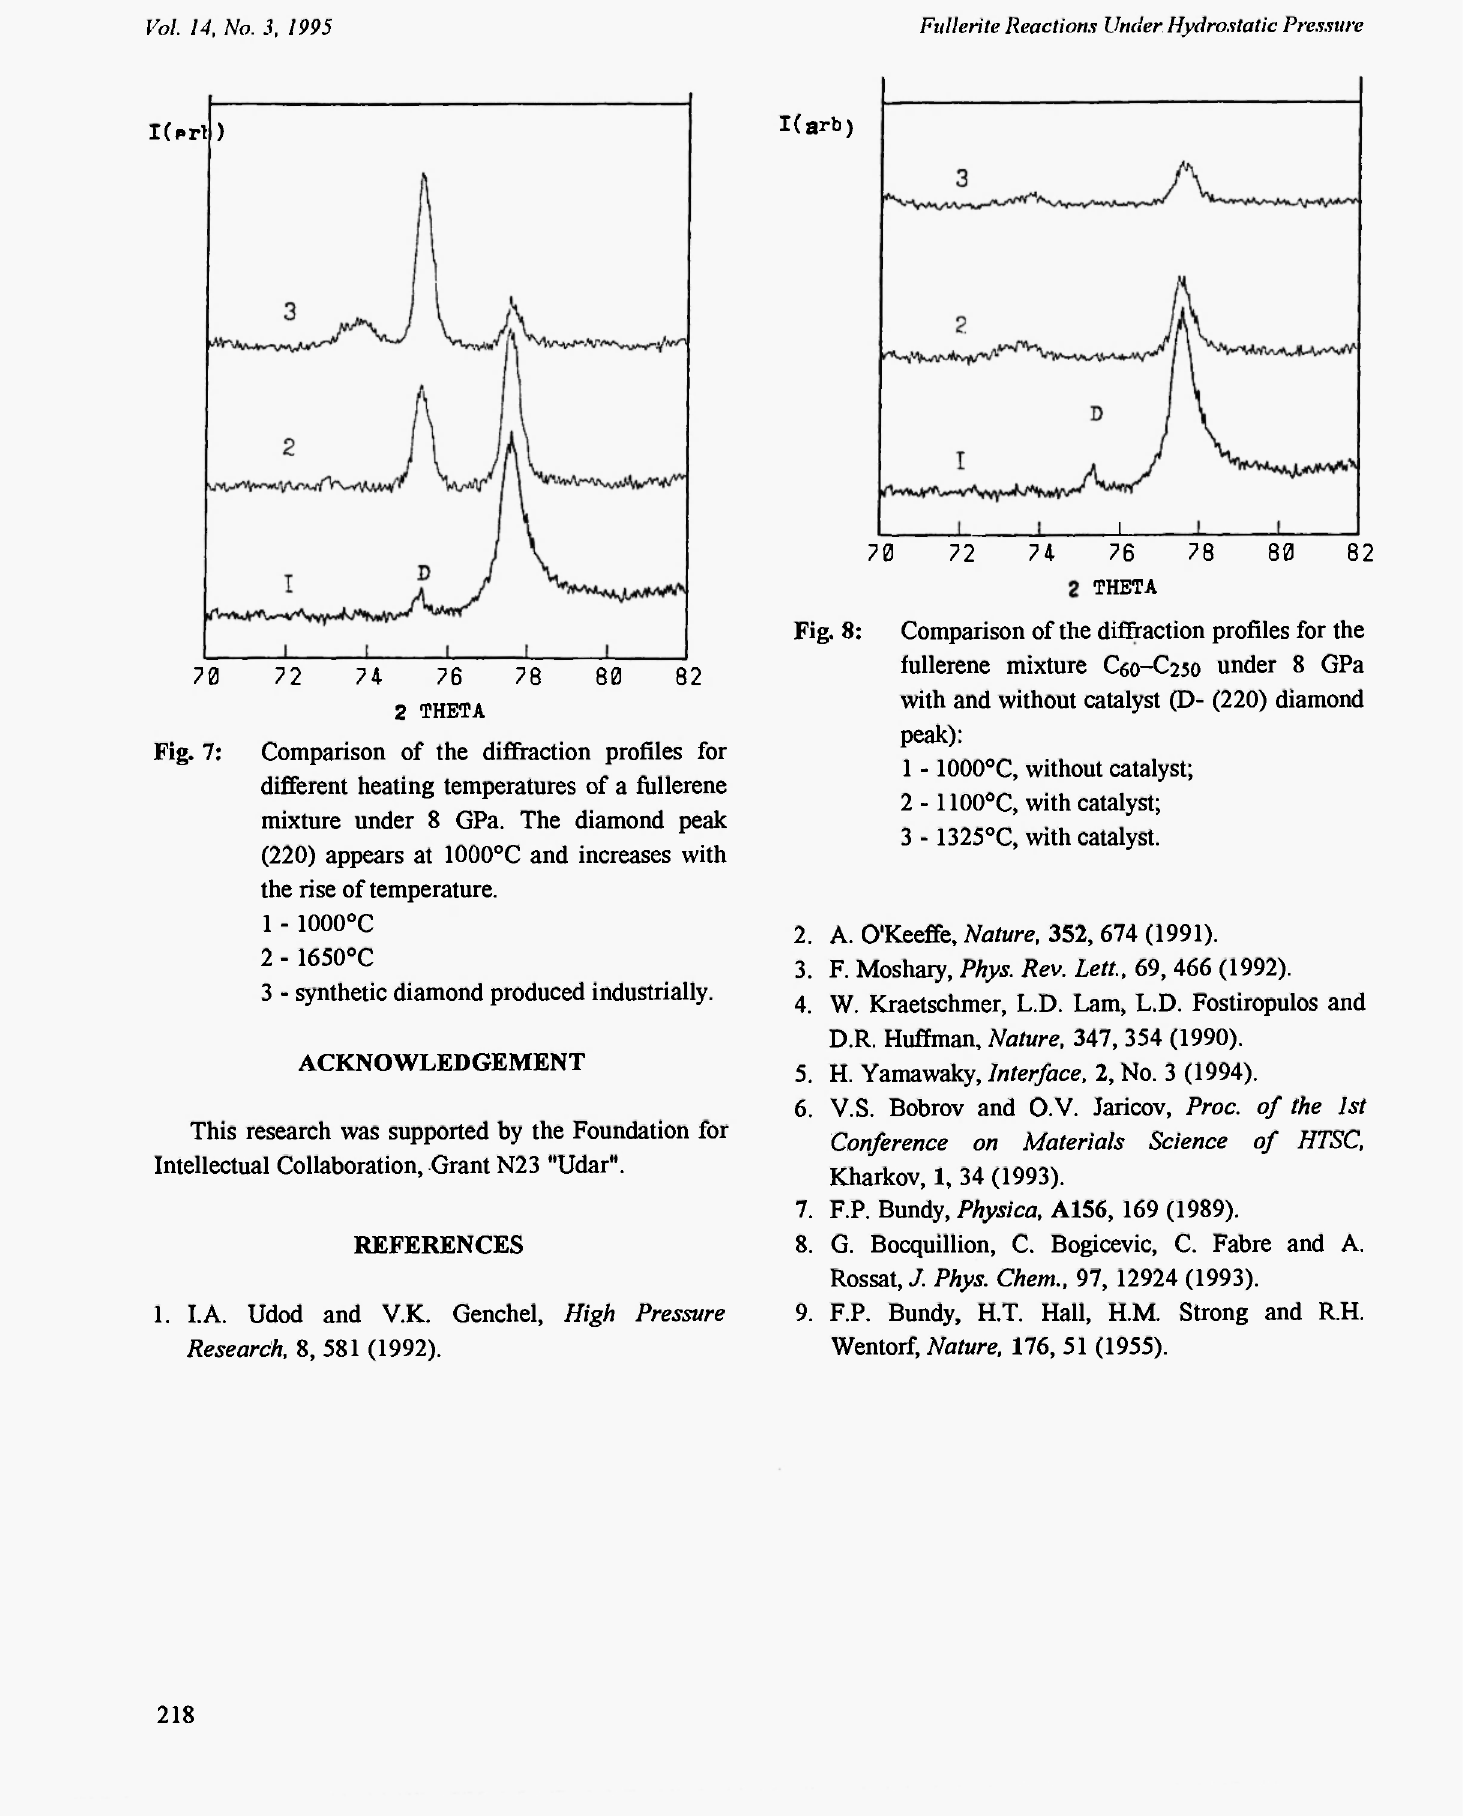
Fig. 8: Comparison of the diffraction profiles for the fullerene mixture C60-C250 under 8 GPa with and without catalyst (D- (220) diamond peak): 1 - 1000°C, without